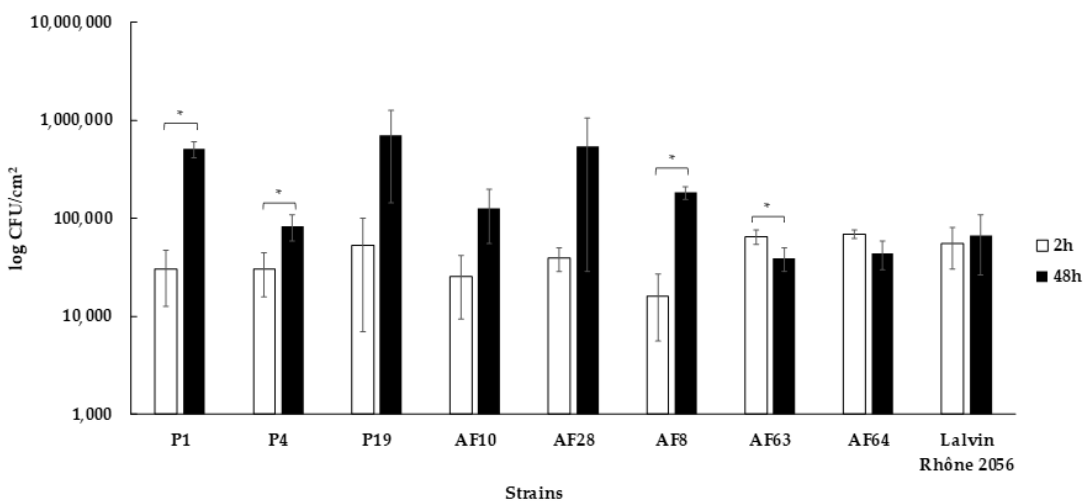
Figure 5. Microcolony growth on stainless steel chips in YPD medium for the selected strains (log CFU / cm 2 ). Errors bars represent the standard deviation between three independent biological replicates. Statistical analysis is performed between the two time points for each strain (ANOVA, p -value ≤